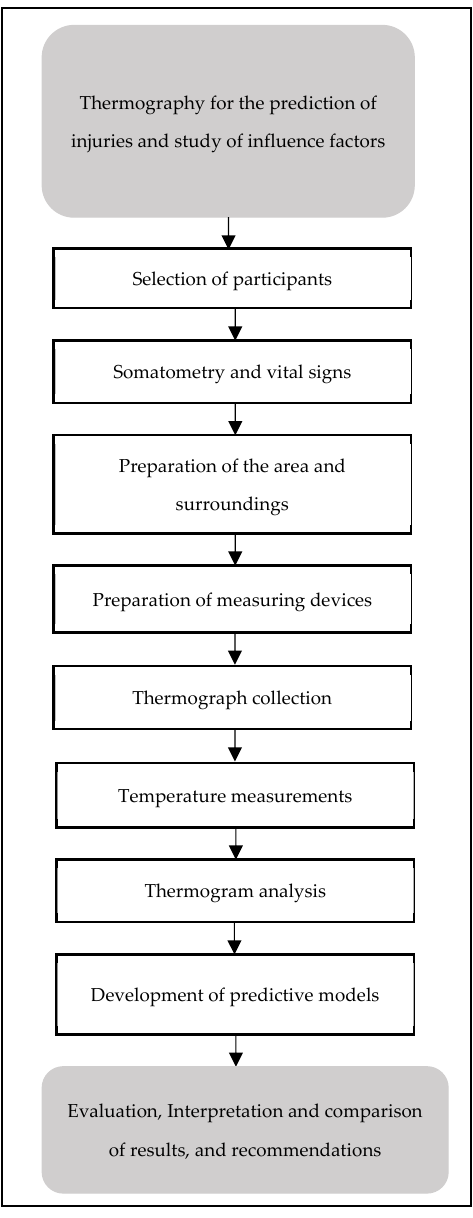
Figure 1. Measurement methodology flowchart.